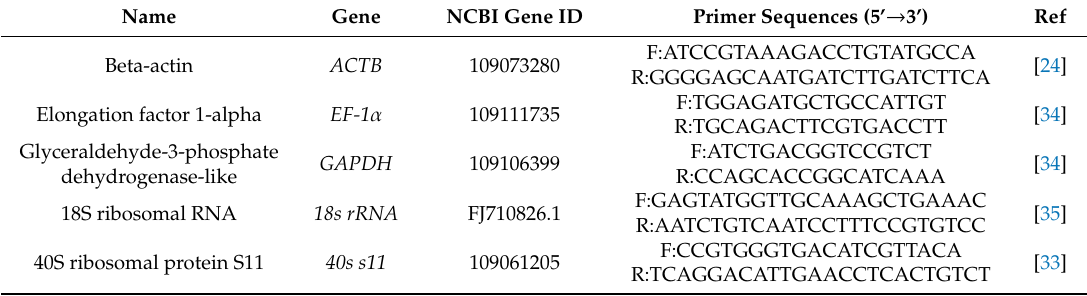
Table 2. Reference genes for reverse transcription–quantitative PCR (RT-qPCR) in common